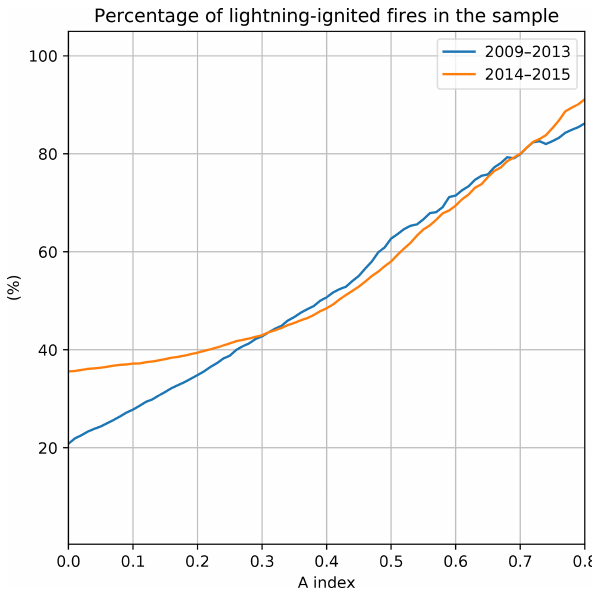
Figure 1. Percentage of LIWs, with different A index values as the threshold, in Spain and France during the period